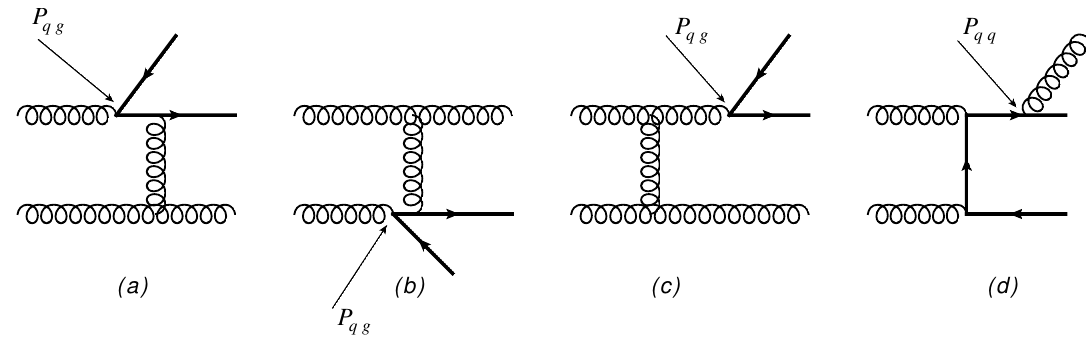
Figure 1 . Diagrams illustrating the origin of four types of collinear logarithms in g + g ! Q + X ! h 3 + X channel. The relevant partonic splitting functions are indicated. Made with JaxoDraw 2.1